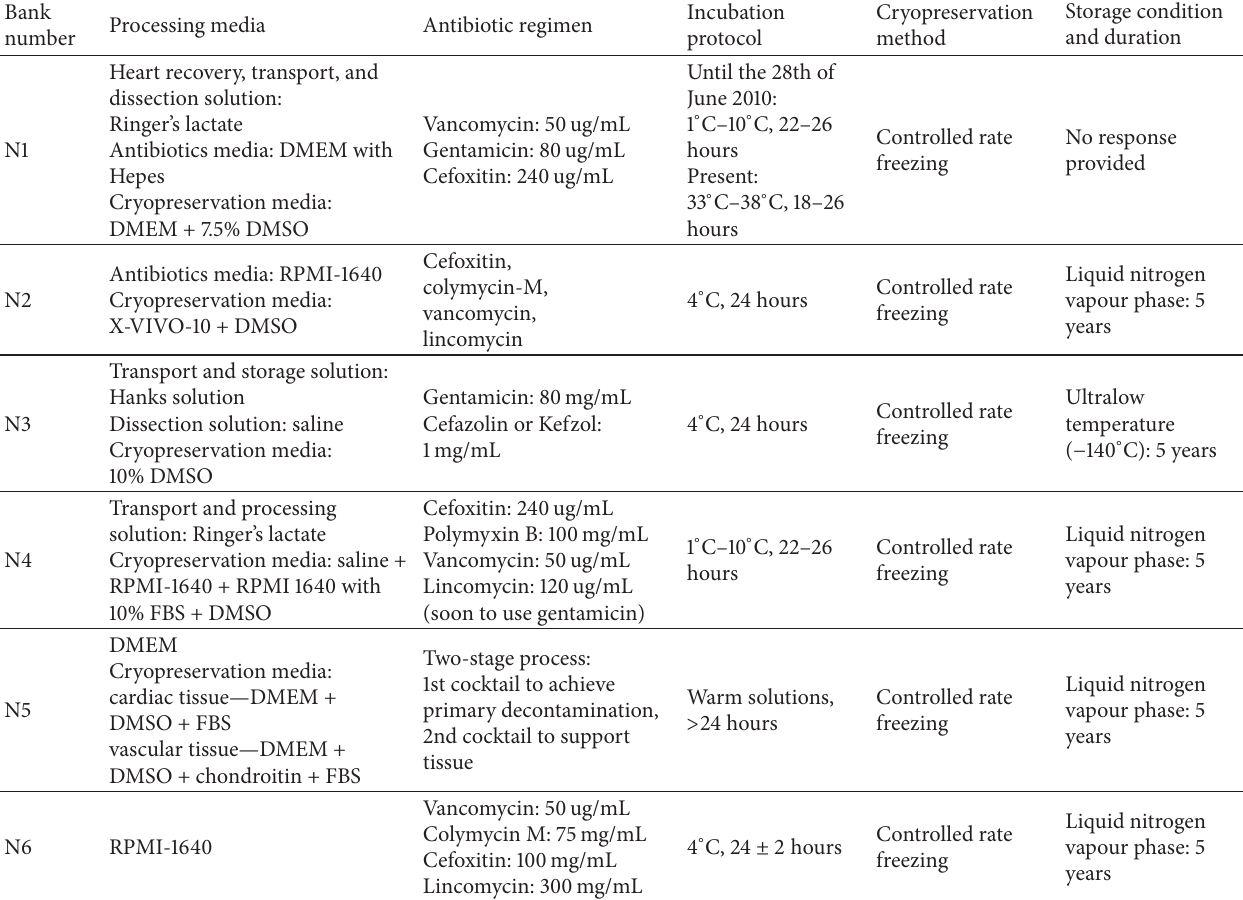
Table 2: Summary of heart valve processing protocols used by HVBs in North